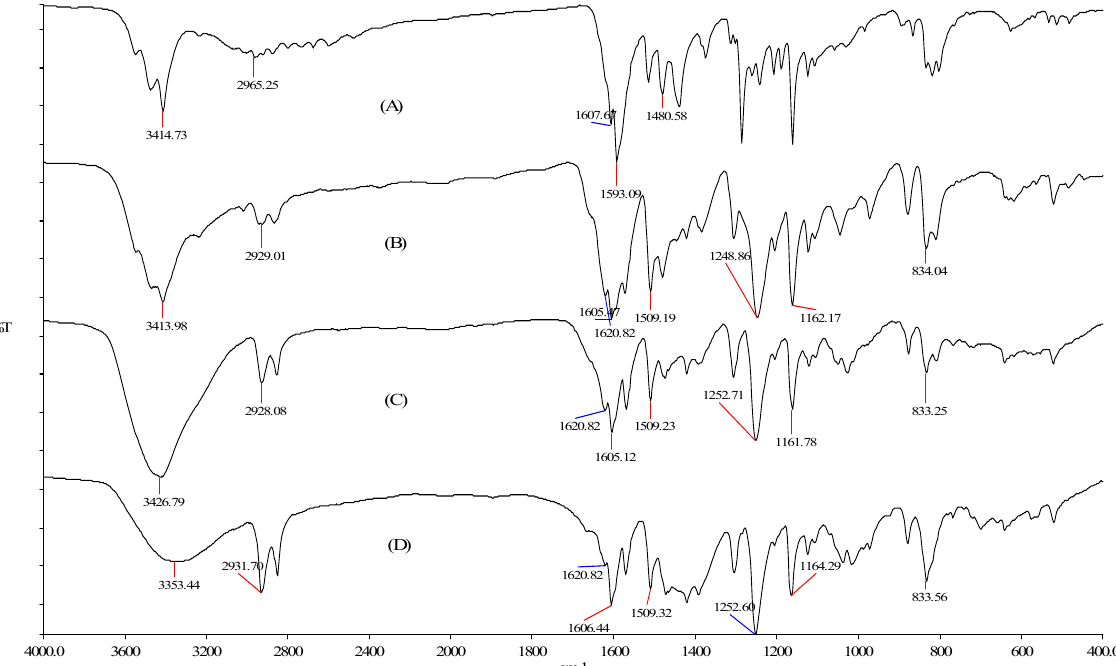
Figure 1. The FT-IR spectra of (A) bisphenol 1 (B) diol 2a, (C) diol 2b and (D) diol 2d .